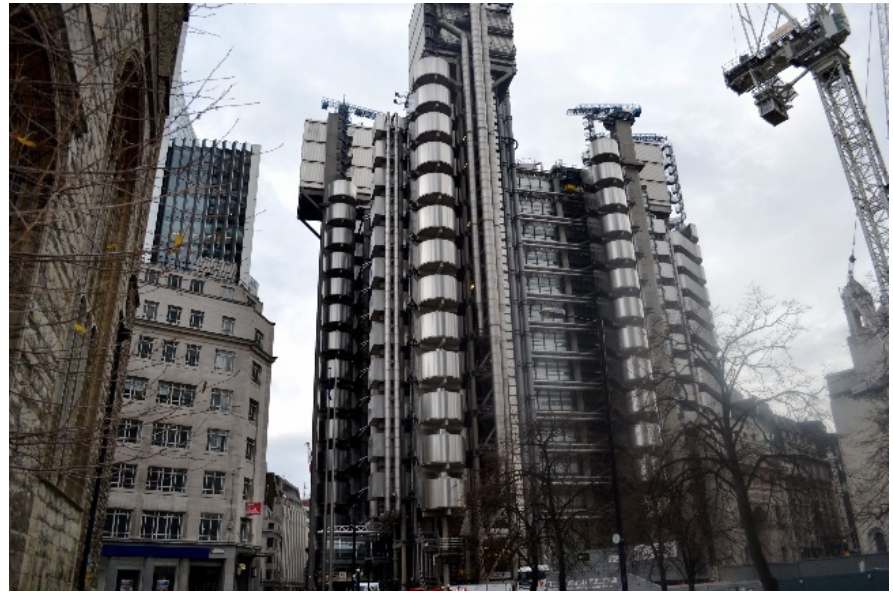
Figure 24. Lloyd’s Building (1986) in London, UK (Center). (Photo by K. Al-Kodmany). Strikingly, new developments and advancements in diagrid structural systems, ex- plained earlier, have enabled architects and engineers to generate “exotic” forms. An advanced diagrid system allows the creation of an elastic mesh capable of conforming to al- most any form or shape. Prominent examples include the Gherkin Building in London, UK; the CCTV Building in Beijing, China; the Capital Gate Building and Al Dar Headquarters in Abu Dhabi, UAE; and the Morpheus Hotel at City of Dreams in Macau, China. The latter building by Zaha Hadid and the CCTV by OMA foster a new trend of diagrid characterized by motion and fluidity through modeling irregular, dynamic forms. Their style gives birth to “diagrid deconstructivism” (Figures 25 and 26). However, unlike mainstream deconstructivism, where the building is decomposed to generate dynamic forms, “diagrid deconstructivism” develops exotic buildings while respecting structural logic and boosting structural efficiency [31]. Further, because of the rise of the Pluralistic architectural style of tall buildings permitting arbitrary, iconic, and “formless” forms embraced by architects, the trend is now toward varied architectural expression based on non-structural considerations. This may, however, be a temporary phase, and the trend will likely change